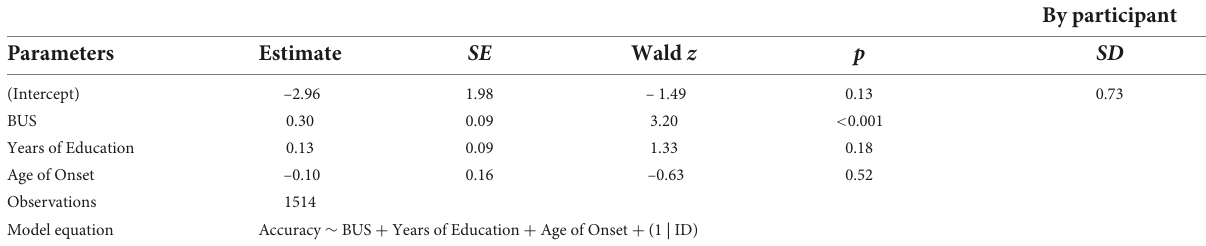
TABLE 7 Regression coefficients of Bosnian Usage Score (BUS) on case marking accuracy of heritage